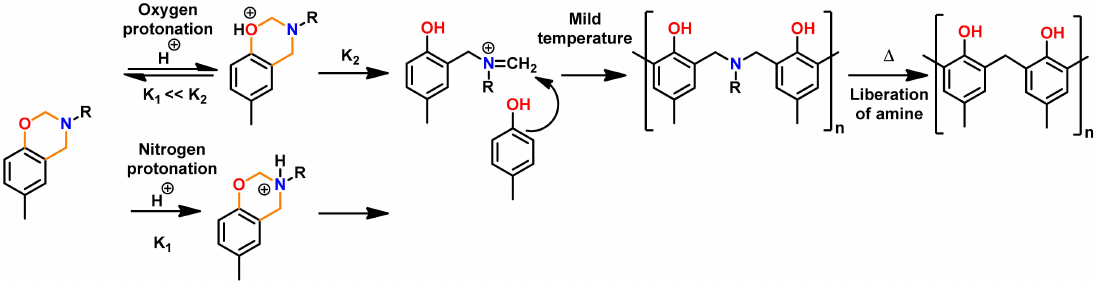
Figure 36. ROP of Bz monomers initiated by proton catalyst [271]. Ishida et al. [266] reported the use of phenols with a free o -position (BA, poly( p - hydroxystyrene), 2,2’-dihydroxybenzophenone and 2,6-di-tert-butyl- p -cresol), with mild and strong organic and mineral acids (acetic, adipic, sebacic, benzoic, sulfuric, p -toluenesulfonic, phosphoric acids) as catalysts for the ROP of Bz monomer. Adipic acid (6 mol%) was found to be the most effective and showed a 17% decrease in the curing parameters. PBzs obtained using strong carboxylic acids were inferior to those formed with weak carboxylic acids. The pK a of the acid appeared to control the interconversion of the reactive intermediate, aminomethyl ester and the iminium ion affecting crosslinking reactions. Figure 37 shows a faster decrease in the normalized areas of the characteristic oxazine ring vibrations at 1050 and 813 cm − 1 in presence of p -cresol (pK a = 10.2) than sebacic acid (pK a = 4.7, 5.4), supporting that the former mediates faster oxazine ring-opening reaction